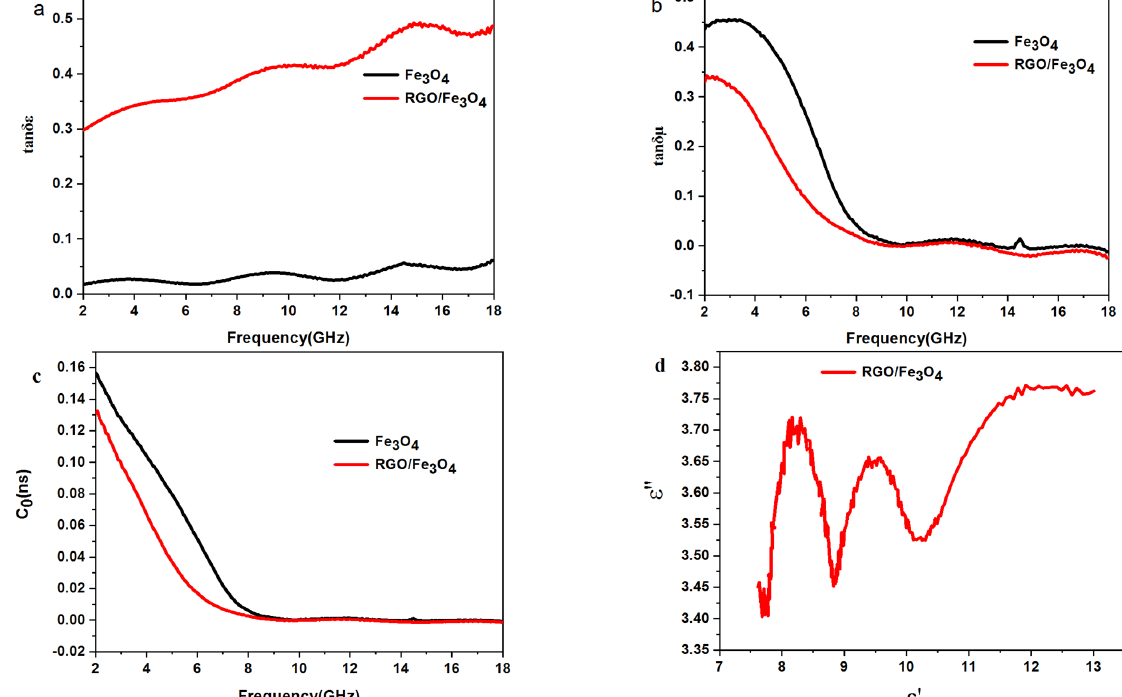
Figure 10. ( a ) Dielectric tangent loss (tan δ ε ), ( b ) magnetic tangent loss (tan δ µ ), ( c ) C 0 values of Fe 3 O 4 nanocrystals and RGO/Fe 3 O 4 nanocomposites, ( d ) Cole–Cole plots of RGO/Fe 3 O 4 composites.